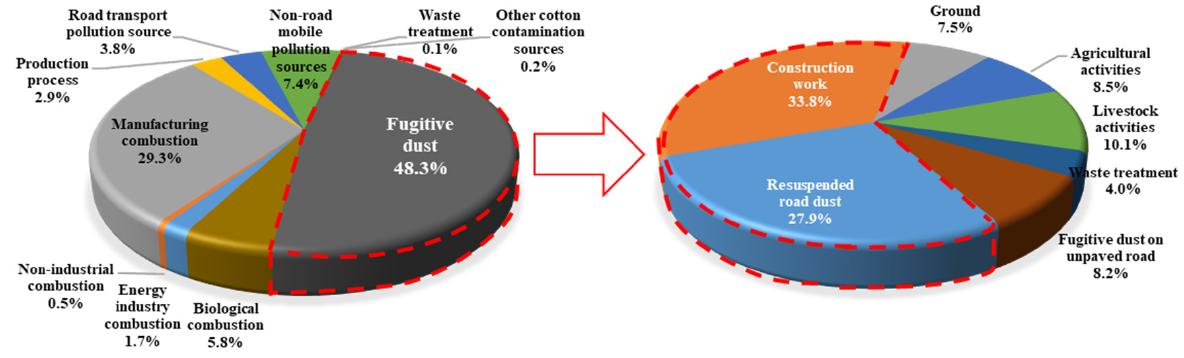
Figure 1. Particulate matter (PM 10 ) emissions as a function of the emission source in Korea (2018).